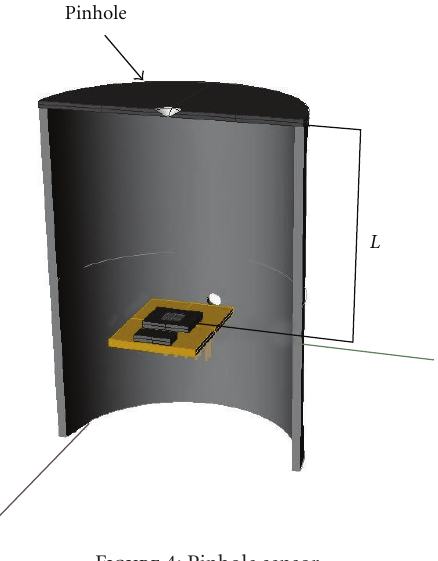
Figure 4: Pinhole sensor.